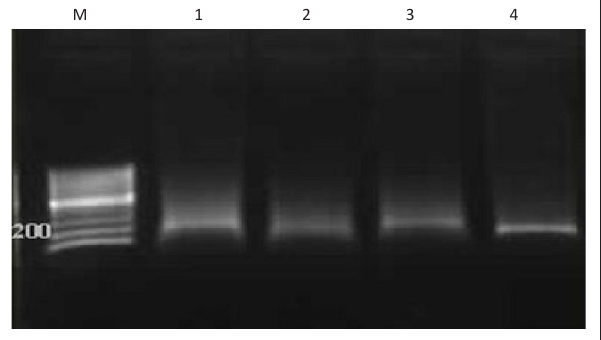
FIGURE 1: Detection of ovine pulmonary adenocarcinoma proviral DNA in the lung tissues by long terminal